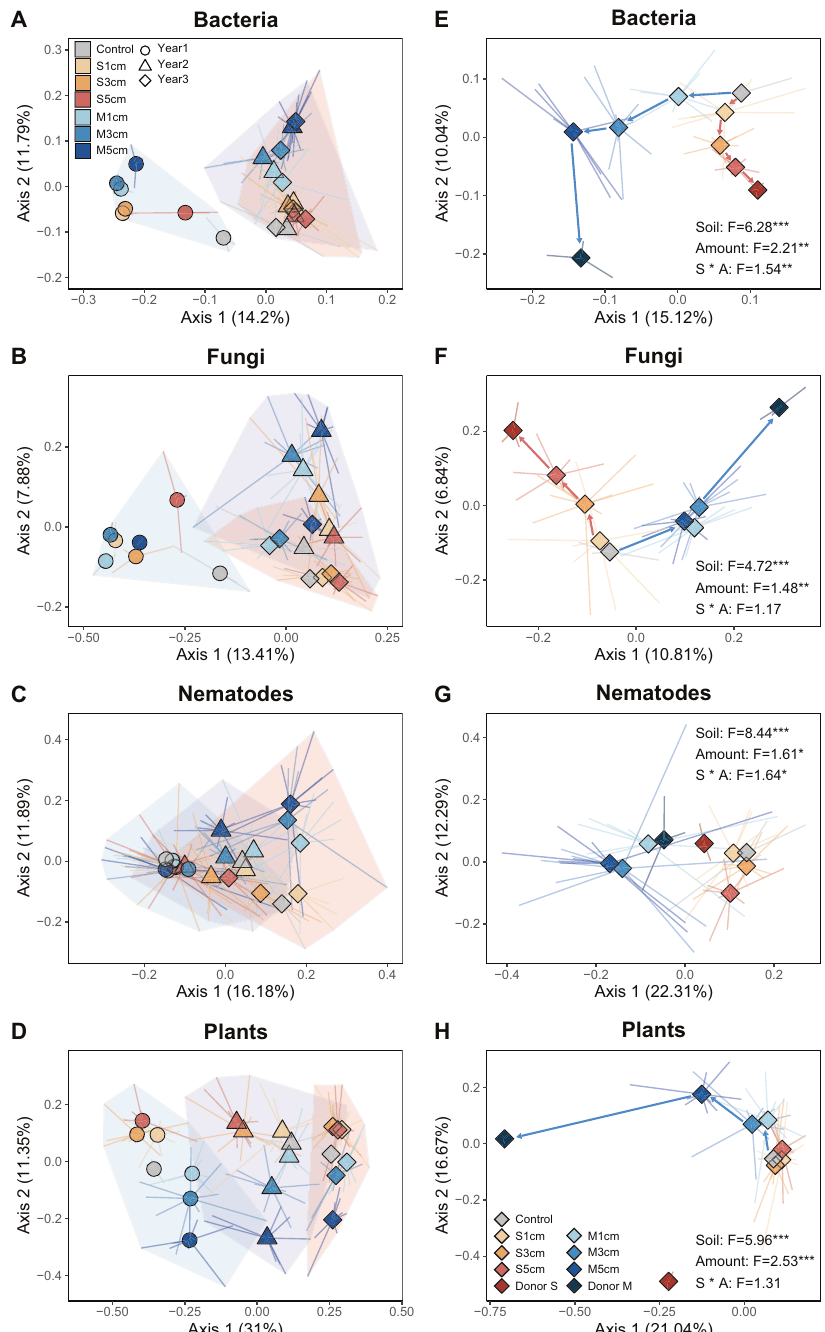
Fig. 2 Effects of soil inoculation on soil bacteria, fungi and nematodes, and plant communities. Separate PCoA ordinations using Bray- Curtis distance are presented for three years ( A , B , C and D ) and for the third year in comparison to the donor ( E , F , G and H ). Percentage of variation given on each axis refers to the explained fraction of total variation. The colors depict soil inoculation treatments: Control, plot without inoculation; S1cm, meadow steppe soil inoculation with 1 cm depth; S3cm, meadow steppe soil inoculation with 3 cm depth; S5cm, meadow steppe soil inoculation with 5 cm depth; M1cm, upland meadow soil inoculation with 1 cm depth; M3cm, upland meadow soil inoculation with 3 cm depth; M5cm, upland meadow soil inoculation with 5 cm depth; Donor S, donor meadow steppe; Donor M, donor upland meadow. The different shapes and shaded areas jointly represent plots in different years: circle, for the fi rst year; triangle, for the second year and rhombus, for the third year. The endpoint of each line represented the replicated sample points in each treatment. The result of PERMANOVA for three years were showed in Table 1 and for the third year were listed above, * P < 0.05; ** P < 0.01; *** P < Soil inoculum identity and amount steer plant communities donor soils originating from a similar ecosystem can steer the soil Soil inoculation also signi fi cantly affected plant community compo- communities at the degraded grassland towards the speci fi c sition (Fig. 2D; Table 1) and steered the composition of plant donor community but also, for the fi rst time that in the fi eld, this is communities towards the speci fi c grassland donor sites (Fig. 2H). accelerated when increasing amounts of inoculum are used.